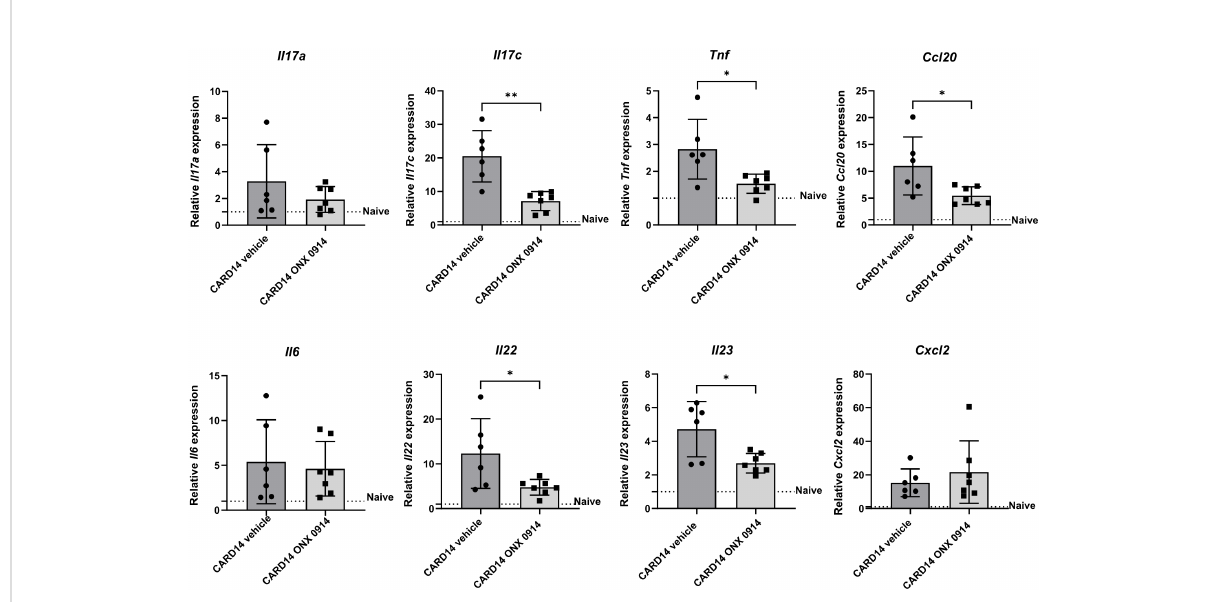
FIGURE 2 Immunoproteasome inhibition reduces the expression of in fl ammatory genes in Card14 D E138 +/- mice: 8-10 weeks old Card14 D E138 +/- mice were treated on alternate days with 10 mg/kg ONX 0914 (n = 7) or vehicle (n = 6) for 20 days. Real-time RT-PCR analysis of ear tissue was performed for Il17a , Il17c , Tnf , Ccl20 , Il6 , Il22 , Il23 , and Cxcl2 . On the g -axis, the relative expression of each gene is depicted. Naïve C57BL/6 mice were used as a control indicated by the dotted line. Data were analyzed following the 2 – DD Ct method and normalized to hprt. Data were pooled from 2 independent experiments and statistically analyzed by unpaired t-test. Values represent mean ± SD. * p < 0.05, and ** p